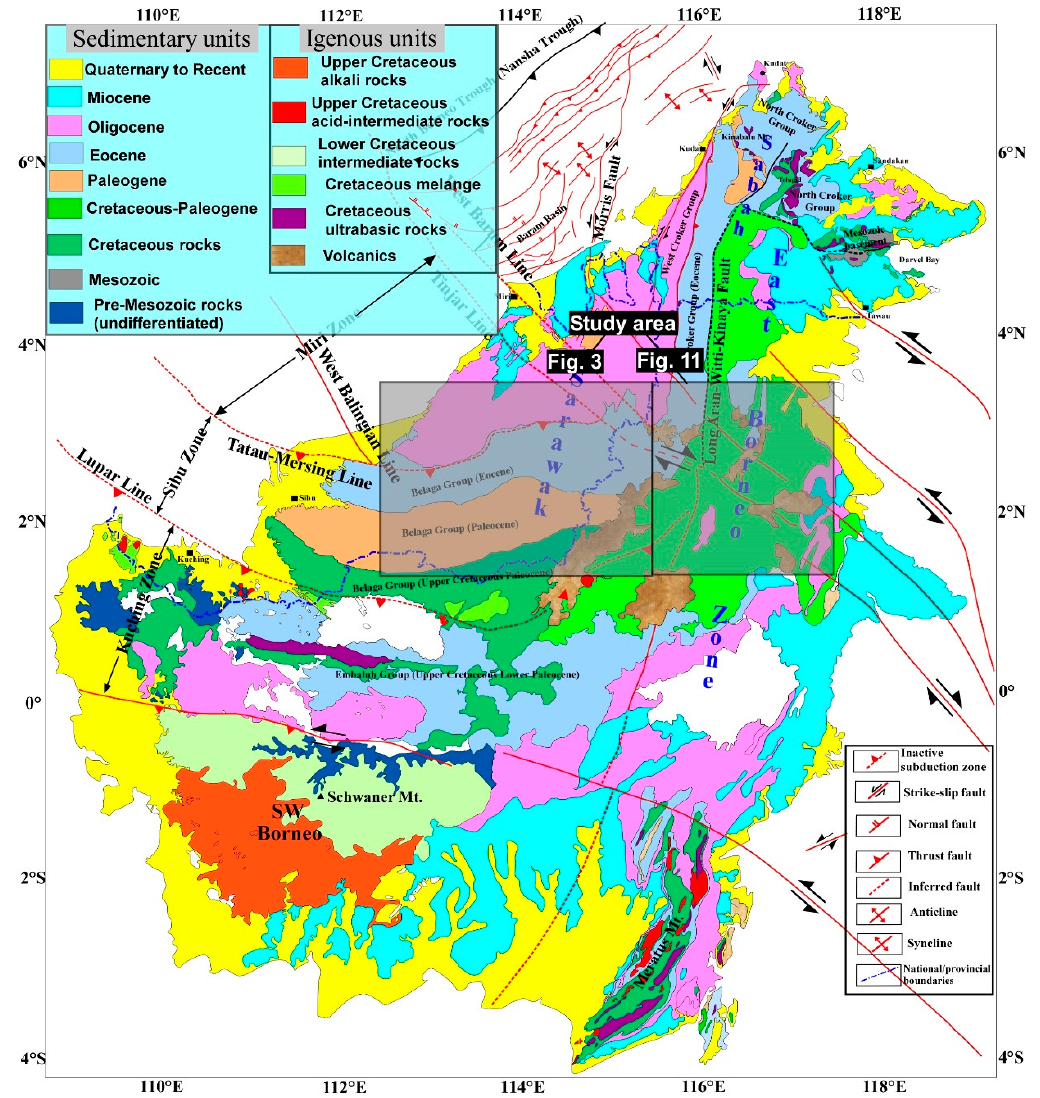
Figure 2. Geological and structural setting of Borneo (modified after [14]). The rectangles show the location of the study area.